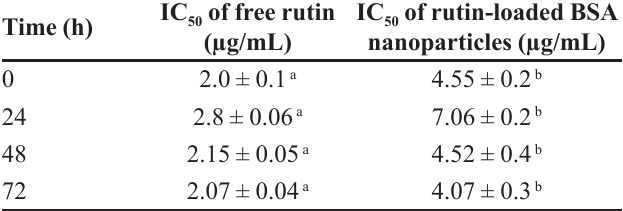
a, b Mean of triplicate ± standard deviation per line analyzed. Same letters mean statistical equality and inequality statistics are shown for different letters (Student’s t test and α 0.05)